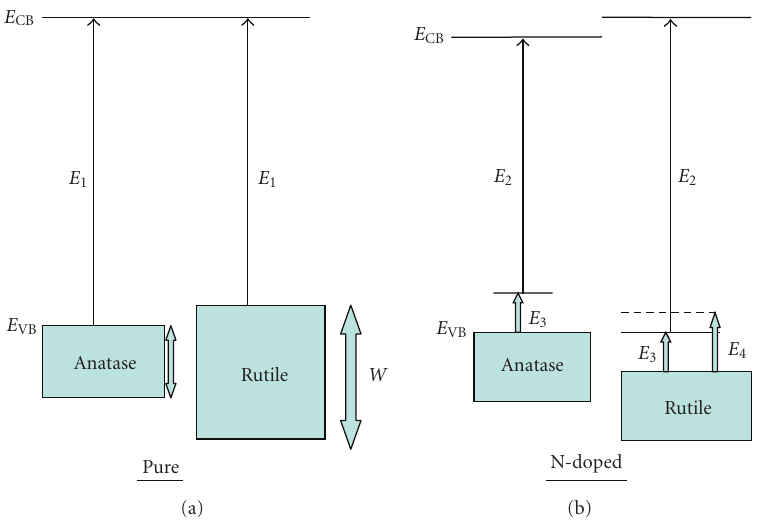
Figure 4: Schematic representation of the energy band structure of pure and N-doped anatase and rutile (energies not to scale). Note the modest shift of 0.03eV in E C of the conduction band to higher energies and the contraction energy E 4 in the N-doped rutile TiO 2 . E 3 represents the energy of the N dopant levels above the valence band. Higher levels of doping, for example, three N atoms per supercell, cause a small shift of ∼ 0 . 05 eV to higher energies for E C which is overcompensated by the presence of N-derived states just above VB, so that the excitation energy E 2 from these states to the conduction band is reduced by < 0.1 eV compared to pure anatase ( W denotes the width of the valence bands). Adapted from results reported in